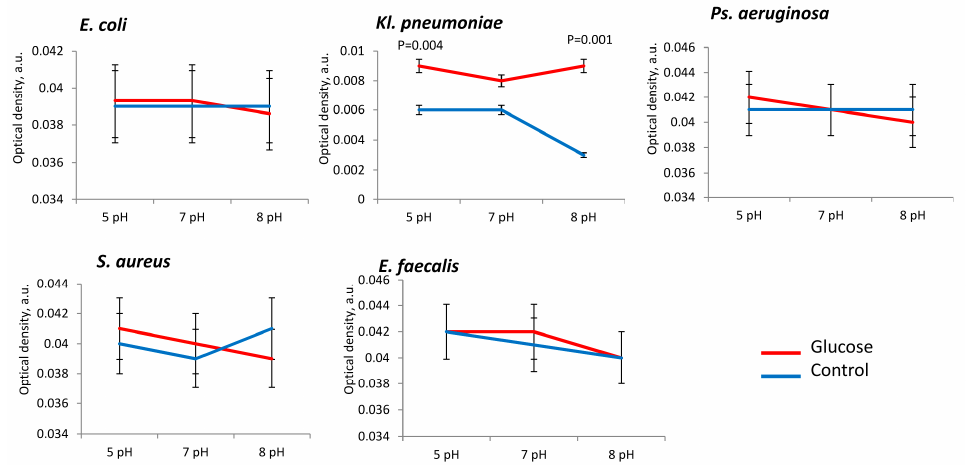
Figure 4. Matrix production of uropathogenic microorganisms is in fl uenced by pH and the pres- ence of glucose in PBS.